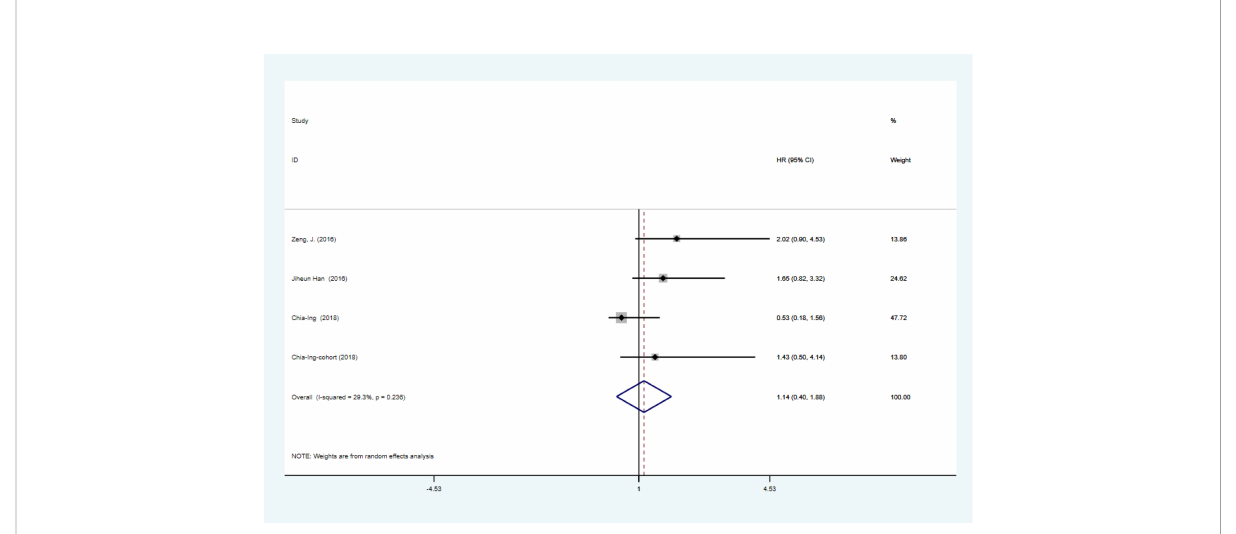
FIGURE 4 Association between PD-L1 expression and PFS of GBM